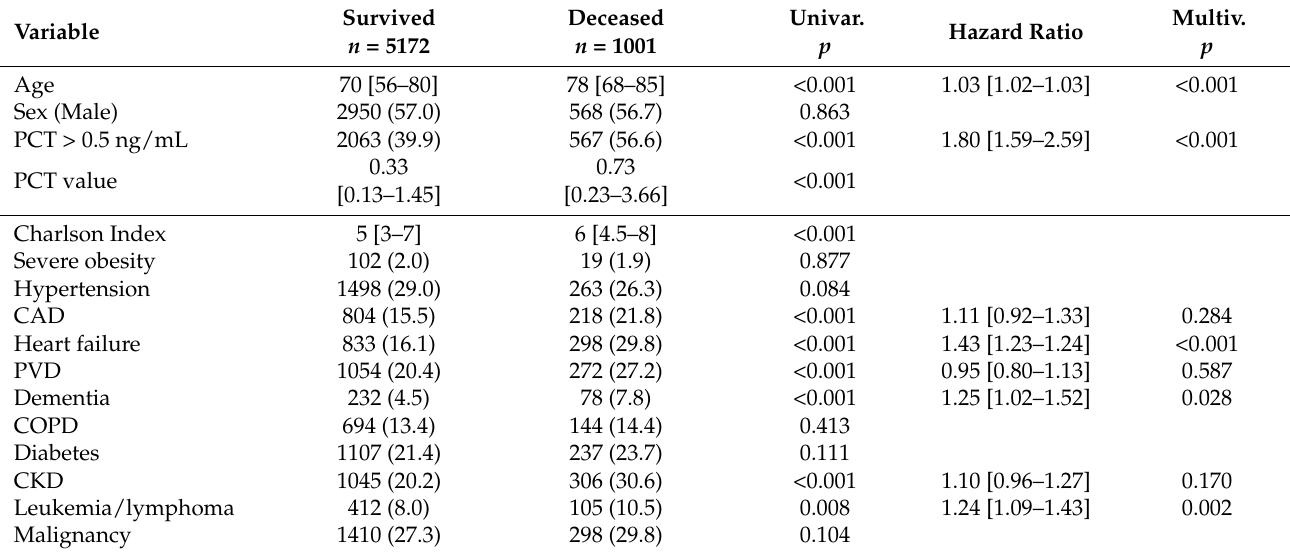
Table 2. Univariate and multivariate analysis for all-cause in-hospital death in patients with a non-septic presentation in the Emergency Department (NSep group).